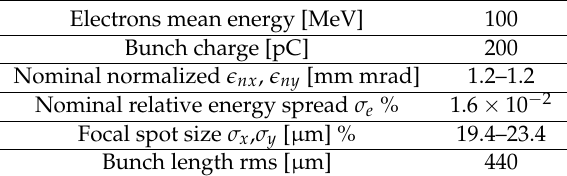
Table 4. Electron beam parameters at the Compton IP.